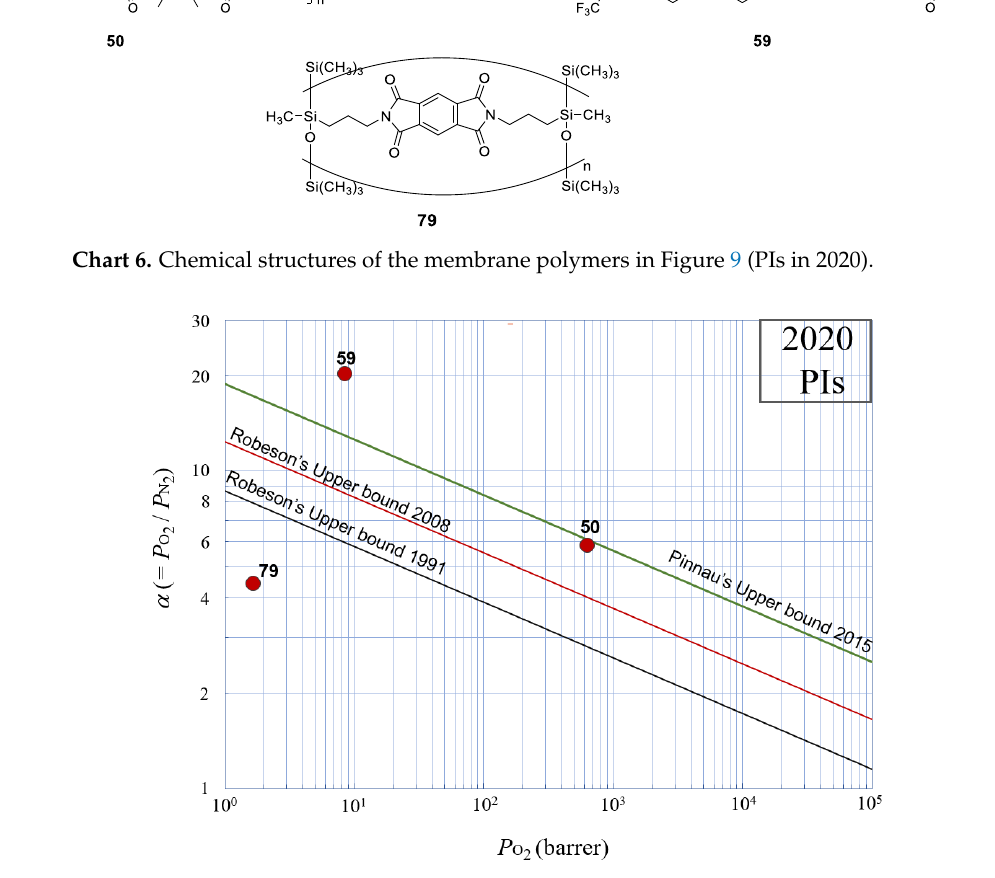
Figure 9. Plots of oxygen permselectivity through polyimides (PI), showing the highest α at each P O 2 reported in the literature in 2020. For the data and categorization of the plots, see Table 7, and for the chemical structures of the polymers in the plots, see Chart 6. Table 7. Categorization and detailed data for the membrane polymers in Figure 9 (PIs in 2020).